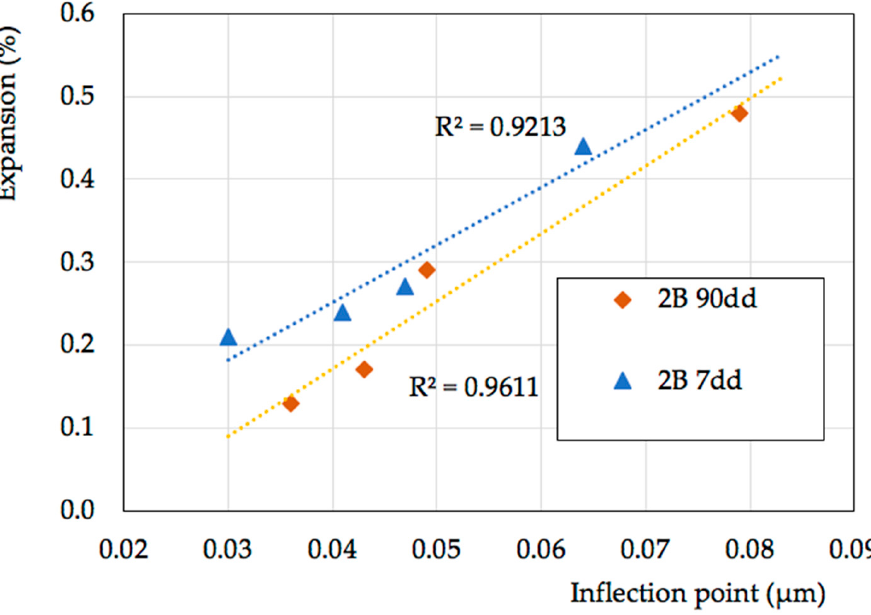
Figure 13. Expansion vs. dimension of the most frequent pore for samples 2B at 7 and 90 days at the shorter curing times (R 2 values for linear interpolation reported).